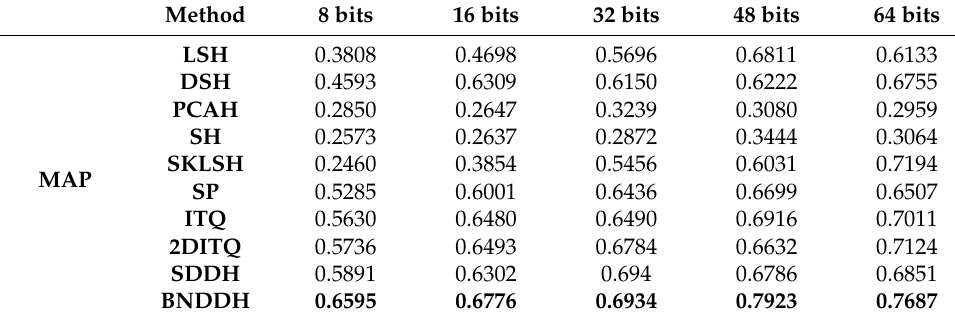
Table 3. MAP of different hash code lengths on the Yale-B database.